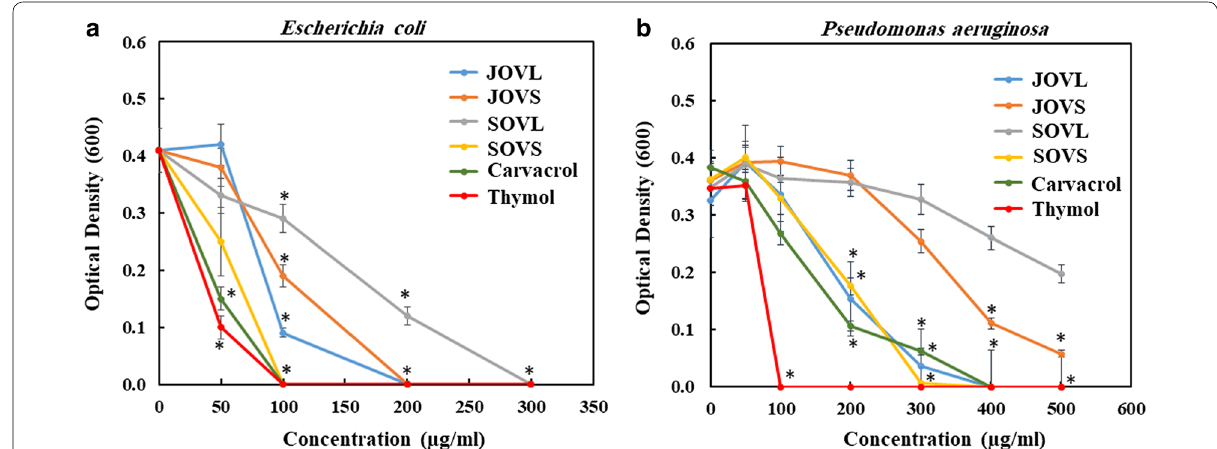
Fig. 4 Change in OD 600 of Gram-negative bacteria ( E. coli ( a ) and P. aeruginosa ( b ) following treatment with different samples. Asterisk indicates the values that are significantly different from the control ( p value < 0.005)